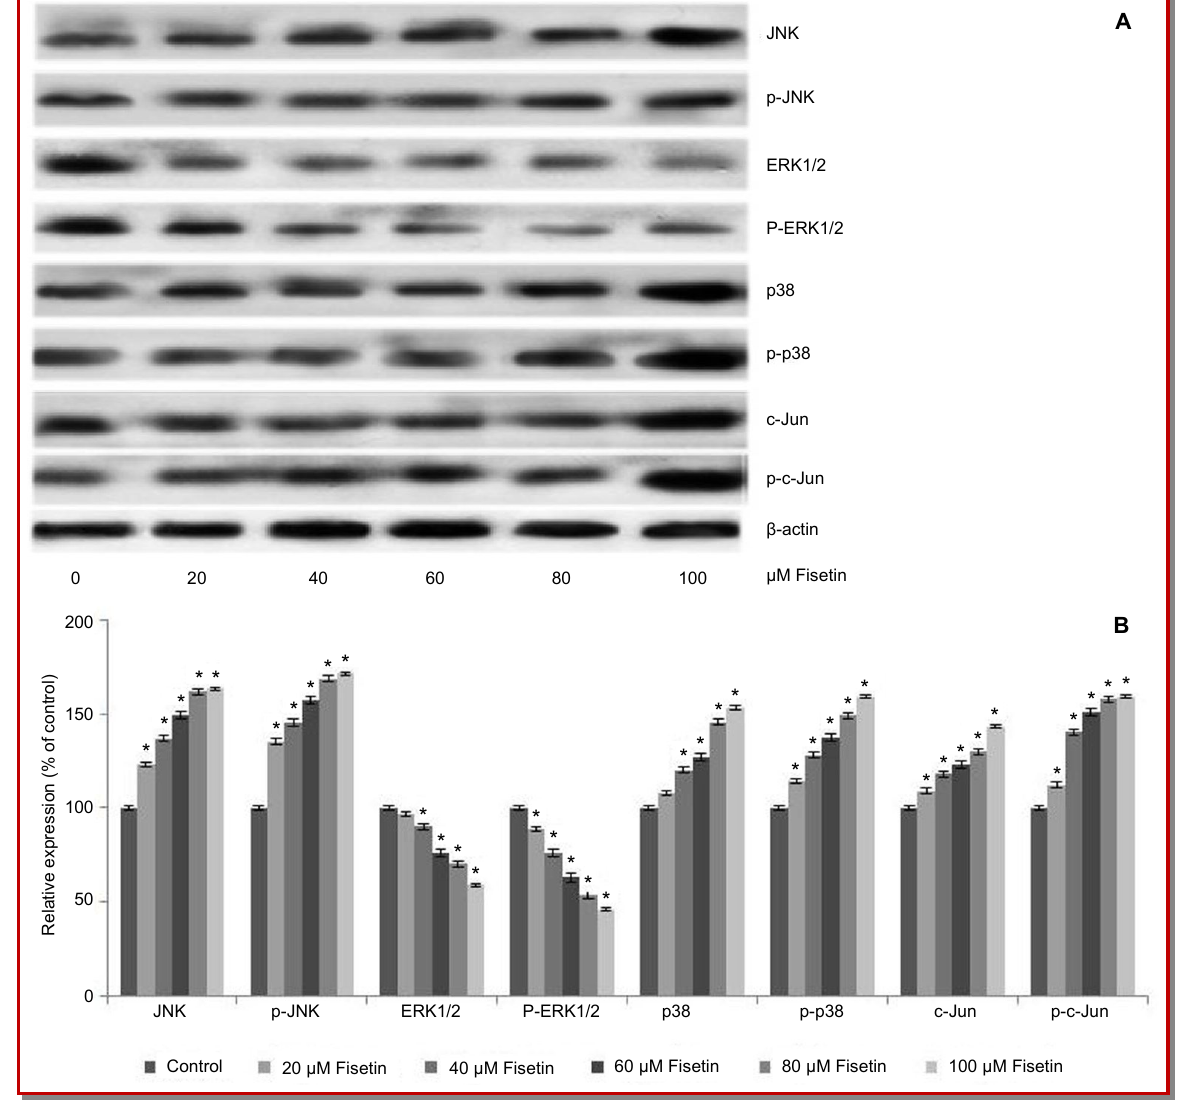
Figure 7: Fisetin regulates the MAPK pathway proteins (A) Significant down regulations of ERK1/2 with marked increase in the expressions of JNK and c-Jun were observed following fisetin exposure. Marked up-regulations in the phosphorylated forms of JNK, c-Jun and p38 were also observed. (B) Relative expressions of the MAP kinases. Values are represented as mean ± SD; n=3; *represents p<0.05 compared with control as determined by one-way